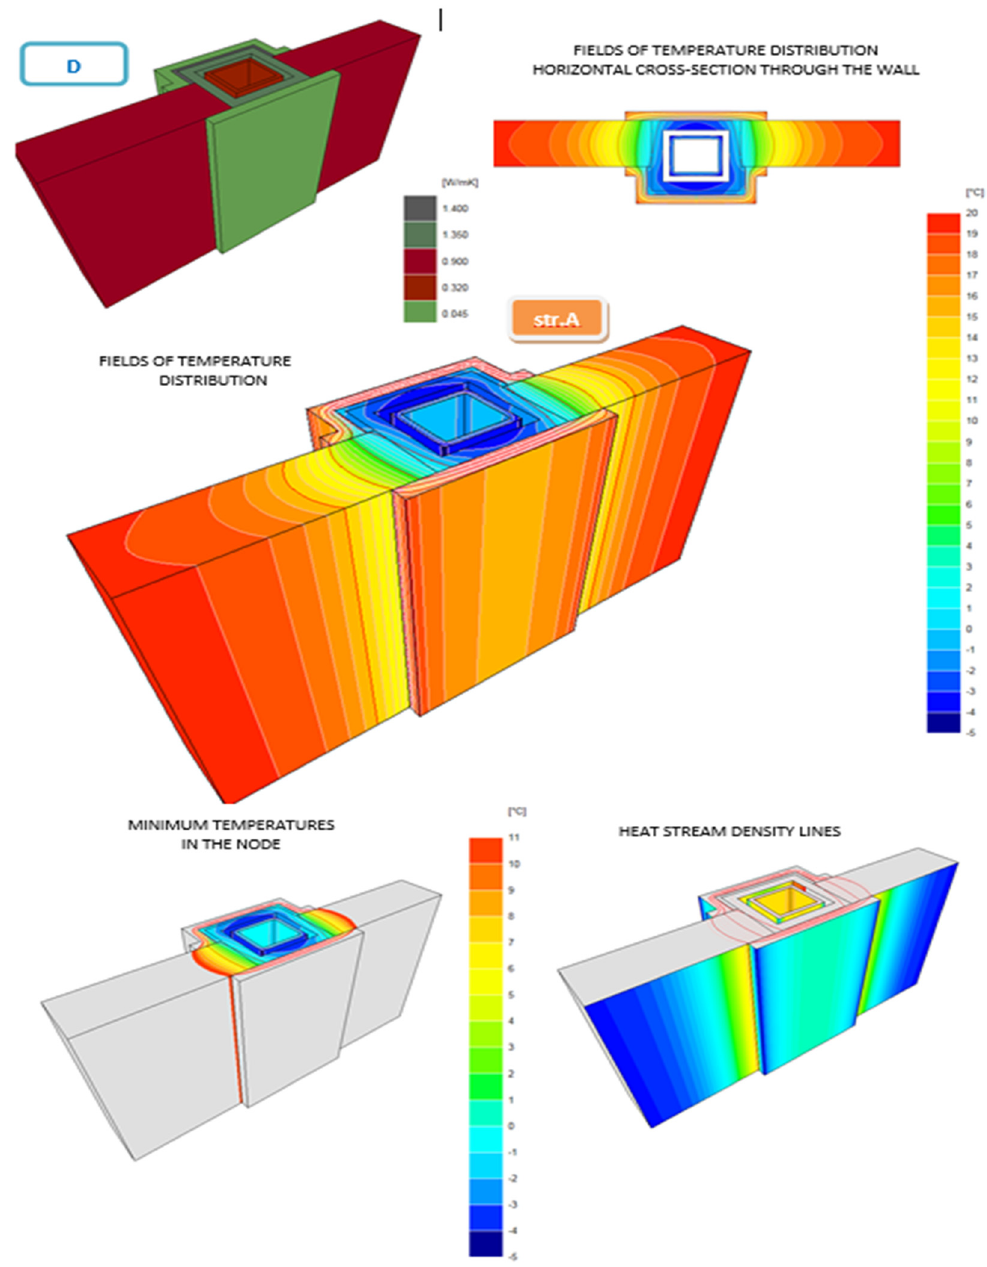
Figure A4. Scheme D: isotherm field distribution, minimum surface temperature, and heat flux distribution.